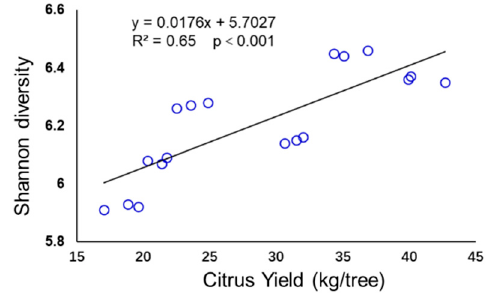
Figure 8. Relationships between citrus yields and Shannon diversity.